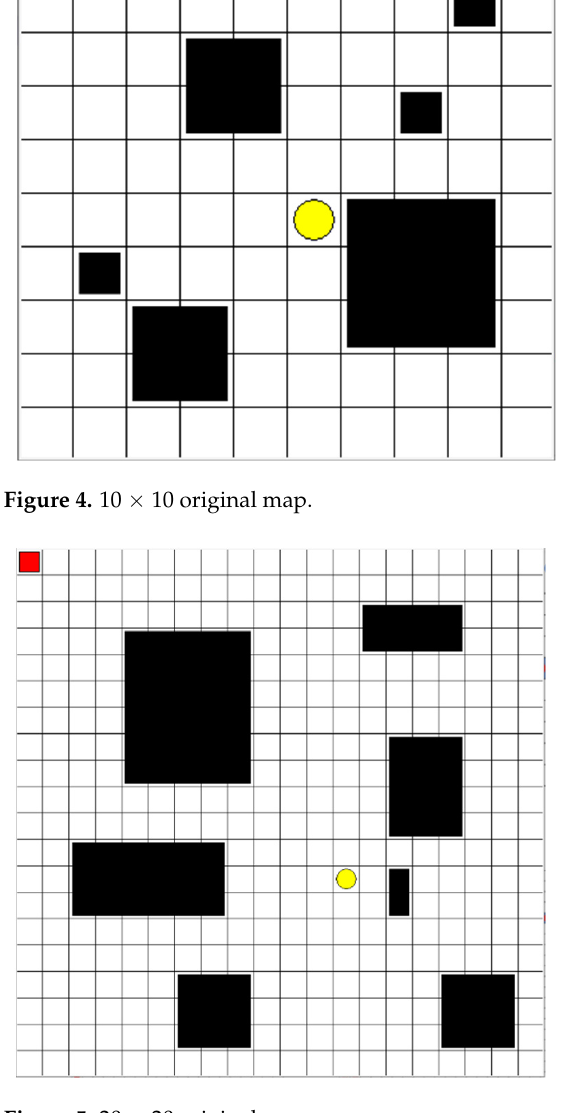
Figure 5. 20 × 20 original